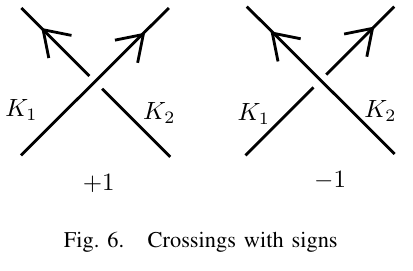
Fig. 6. Crossings with signs